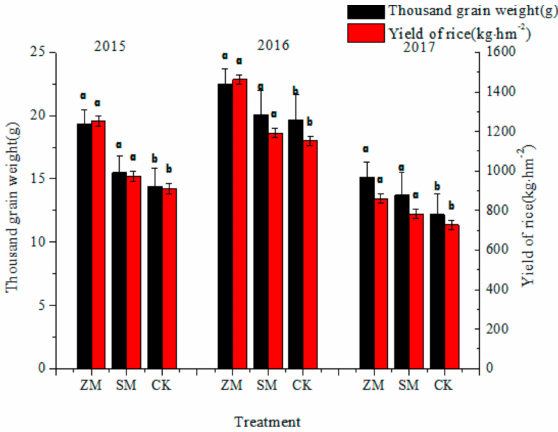
Figure 6. E ff ect of di ff erent films mulching on rice yield.